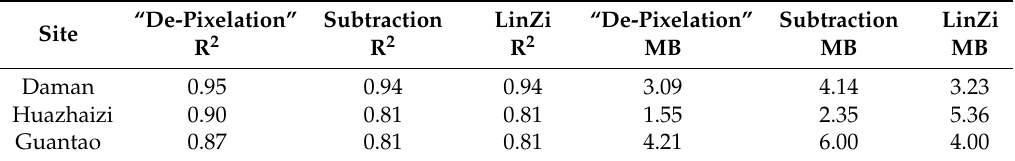
Table 7. Comparison among the results of the three downscaling methods using in situ data from the study